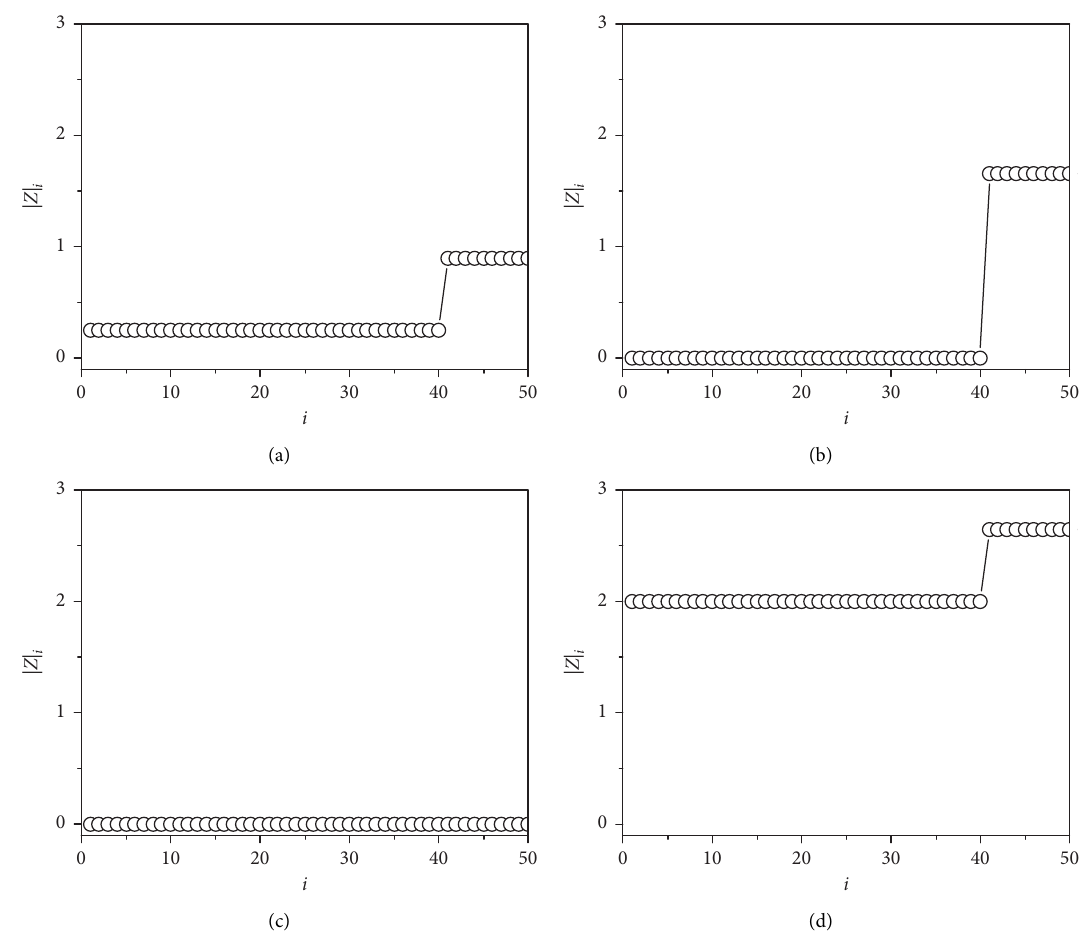
􏽱 ������ | � x 2 + y 2 vs. i for the parameters κ � 2 and δ � 0 . 1 (a), κ � 2 and δ � 0 . 4 (b), κ � 6 and δ � 0 . 1 (c), and κ � 6 and i i i